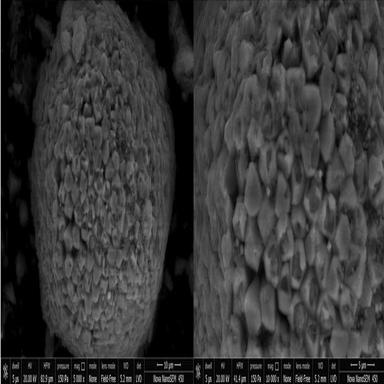
Pyrite Framboidal structures observed in sediment samples.